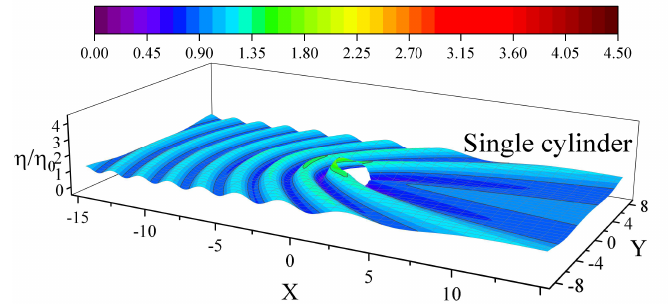
Figure 7. The free-surface elevation η / η 0 of single cylinder at k 0 a = 1.68.